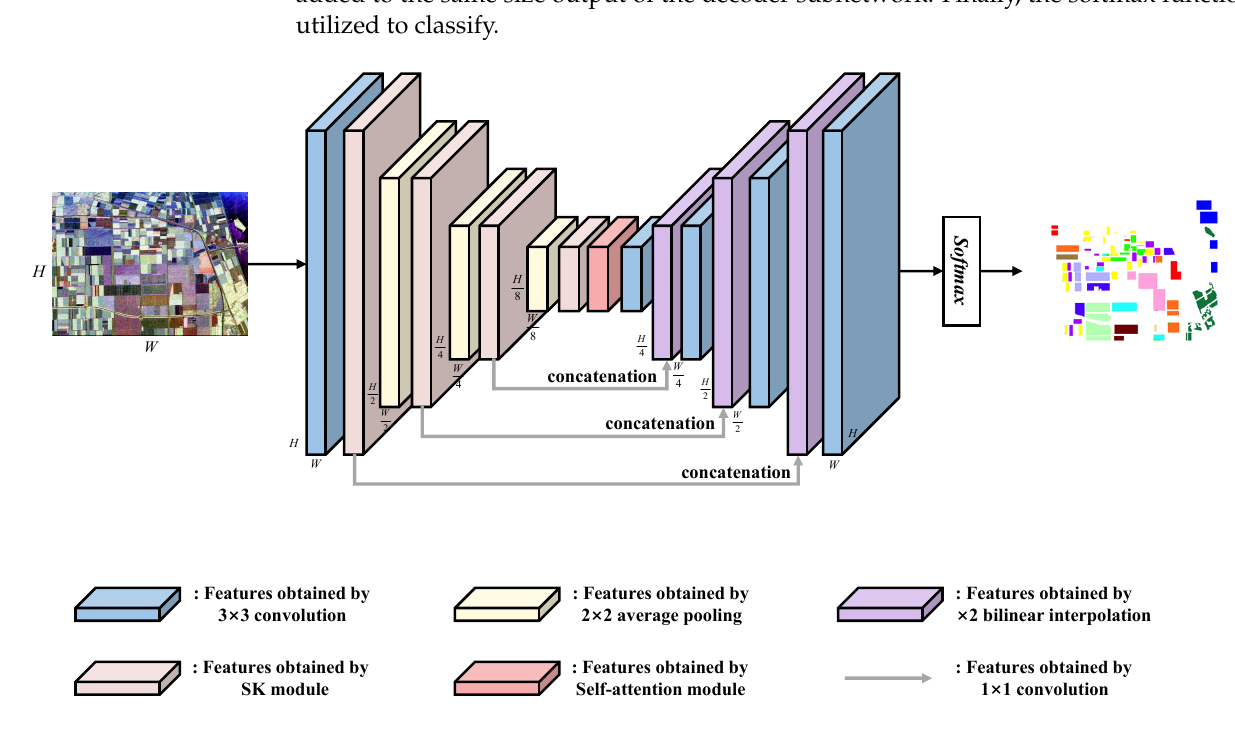
Figure 3. Illustration of the architecture of the HA-EDNet.